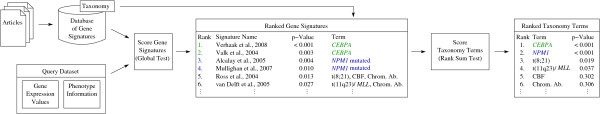
Overview of the analysis process. The proposed method relies on a manually curated database of leukemia-related published gene signatures annotated with terms from a predefined taxonomy. A new microarray dataset is analyzed in two steps. First, each signature is assessed by the global test method to constitute a ranking among the signatures. Secondly, the results from the first step are used to assess terms from the leukemia taxonomy that represent leukemia-related genetic aberrations and molecular mutations.